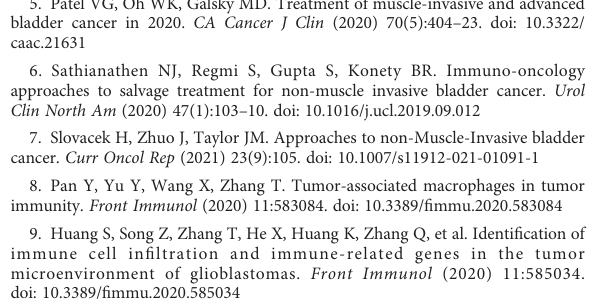
SUPPLEMENTARY FIGURE 1 The whole fl owchart of the study. SUPPLEMENTARY FIGURE 2 The Venn plot of 259 intersection TILRGs. SUPPLEMENTARY FIGURE 3 The Kaplan-Meier curve survival analysis of disease free survival (A) , disease-speci fi c survival (B) , and progression free survival (C) in the high- and low-risk groups. SUPPLEMENTARY FIGURE 4 qRT-PCR results of eight TILRGs expression levels. (A) GNLY, (B) SLFN11, (C) DOCK8, (D) CD3G, (E) ADCY7, (F) ST8SIA4, (G) BTN3A1, (H) ALDH1A1. ns not signifcance, * P < 0.05, ** P < 0.01, and *** P < 0.001. SUPPLEMENTARY FIGURE 5 Immunohistochemistry showing 8 genes expression levels of BCa patients in HPA database. (A) ADCY7, (B) ALDH1A1, (C) BTN3A1, (D) CD3G, (E) DOCK8, (F) GNLY, (G) SLFN11, (H)